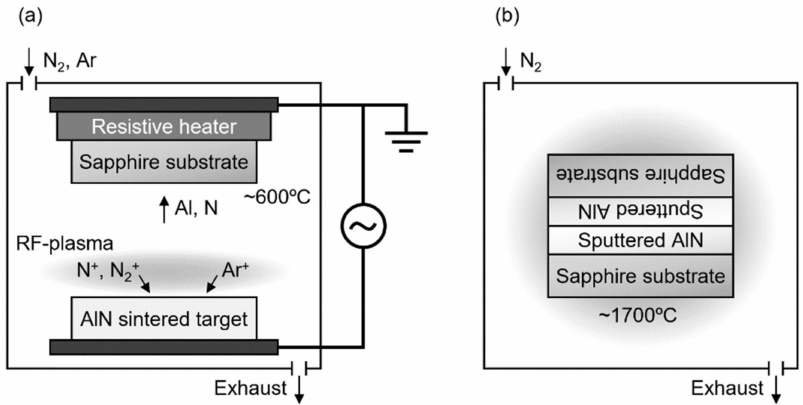
Figure 1. Schematic illustrations of ( a ) RF sputtering system for AlN deposition, and ( b ) face-to- face